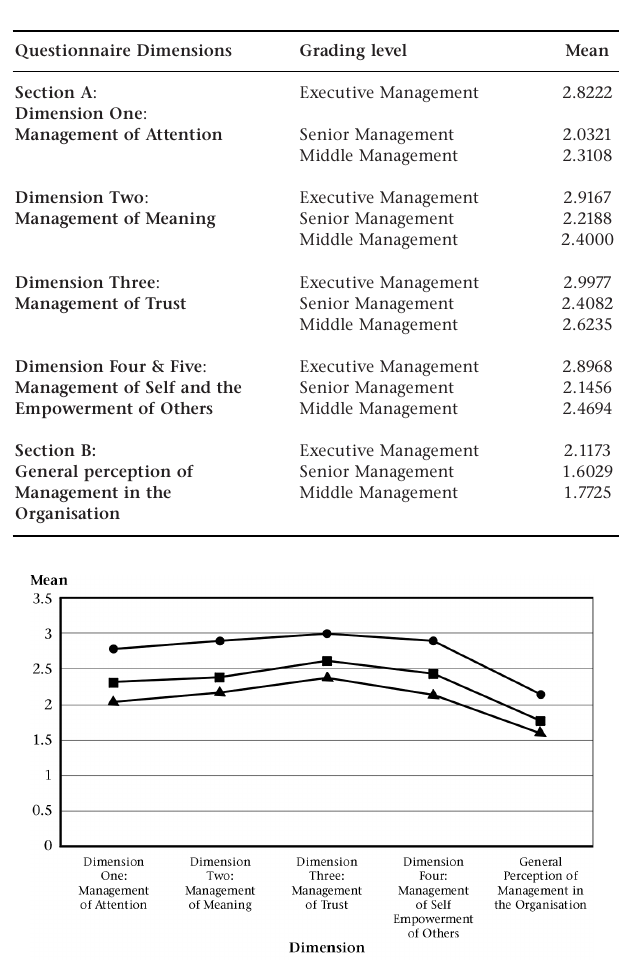
Figure 6: Mean per Dimension per Management Level